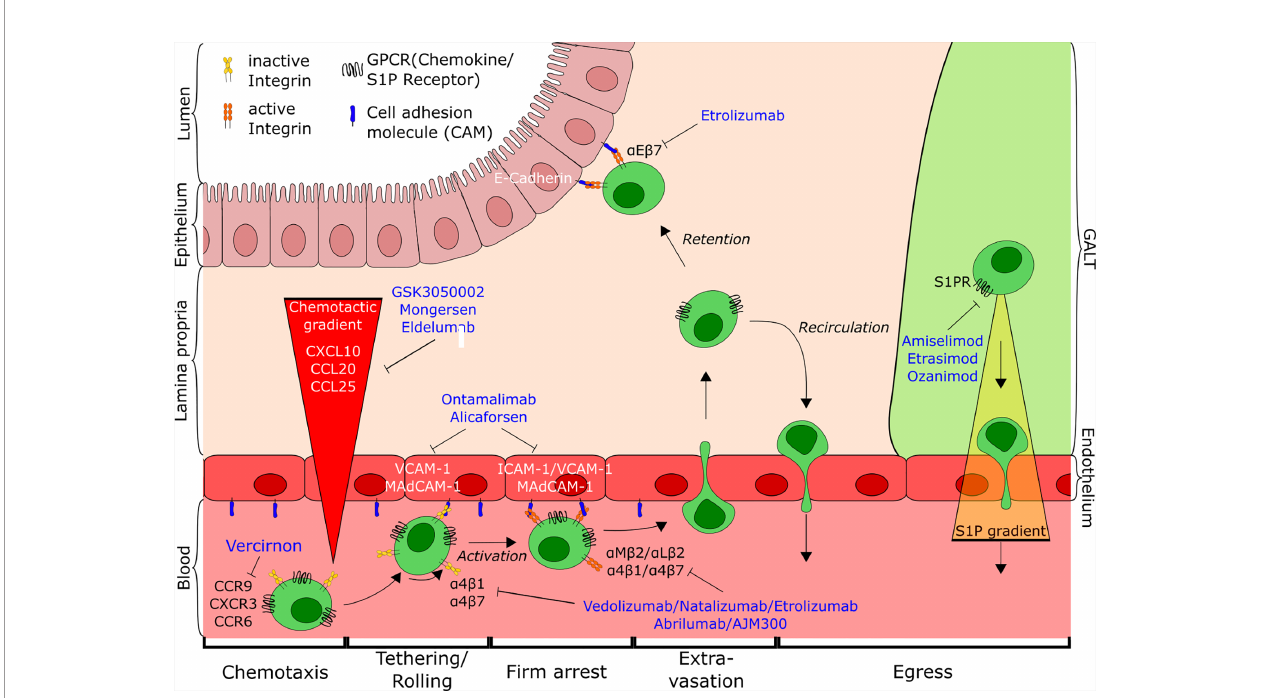
FIGURE 1 | Overview of T cell traf fi cking in the intestine indicating the points of action of current and potential future anti-traf fi cking agents for the treatment of IBD. Tethering and rolling of cells on the endothelial wall mediated by interaction of low-af fi nity integrins with their respective ligands (e.g. a 4 b 7-MAdCAM-1) leads to the exposure to a chemokine gradient (CCL25, CXCL10, CCL20). Subsequent activation of cells causes conformational changes of the integrins, followed by fi rm arrest and extravasation of T cells to the gut. There, cells are either retained in the tissue through interaction with the epithelium ( a E b 7-E-cadherin) or antagonism of egress, or recirculate into the blood from gut and GALT along the S1P-gradient. CD, cluster of differentiation; CCR, Chemokine receptor; CXCR, CXC-motif chemokine receptor; GPCR, G-protein coupled receptor; S1P, Sphingosine-1-phospate; S1PR, Sphingosine-1-phosphate receptor; ICAM-1, Intercellular adhesion molecule 1; VCAM-1, Vascular cell adhesion molecule 1; MAdCAM-1, Mucosal addressin cell adhesion molecule-1; GALT, Gut-associated lymphoid